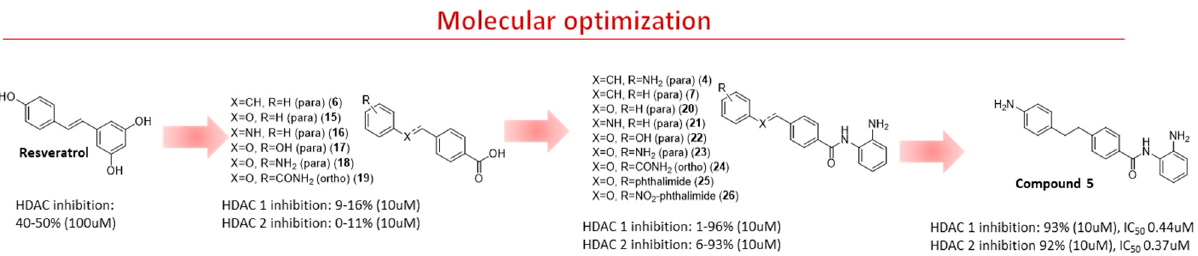
Figure 3. Molecular optimization to design novel RVT derivatives of HDAC-1 and HDAC–2